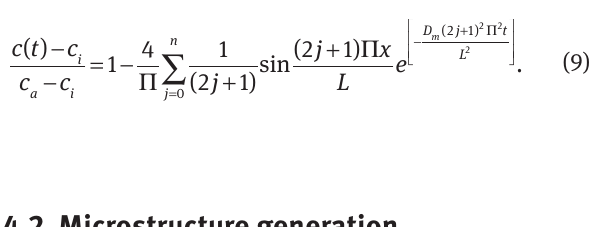
in concentration over left face reaching instantaneously